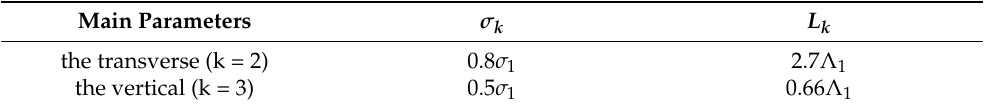
Table 4. Turbulence spectrum parameters of horizontal and vertical